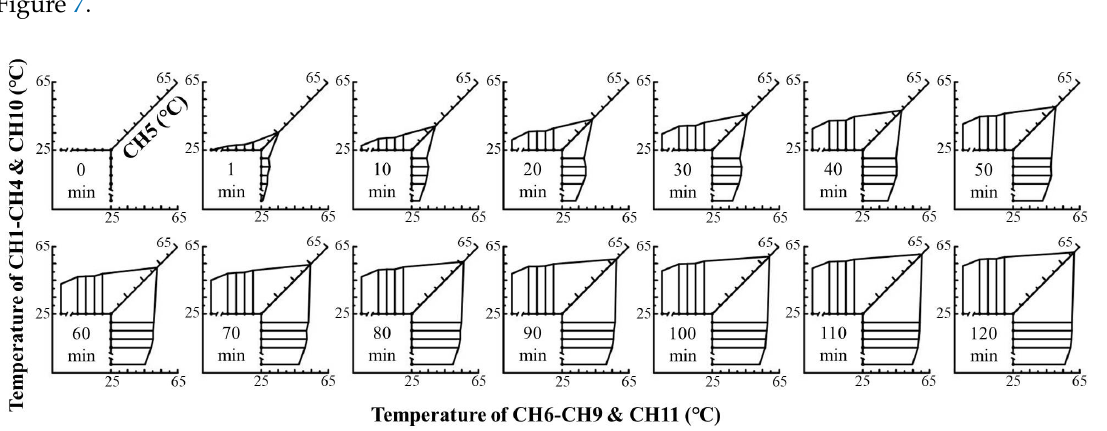
Figure 7. Temperature change in the valve orifice at different times when x = 1 mm and p in = 2 MPa.